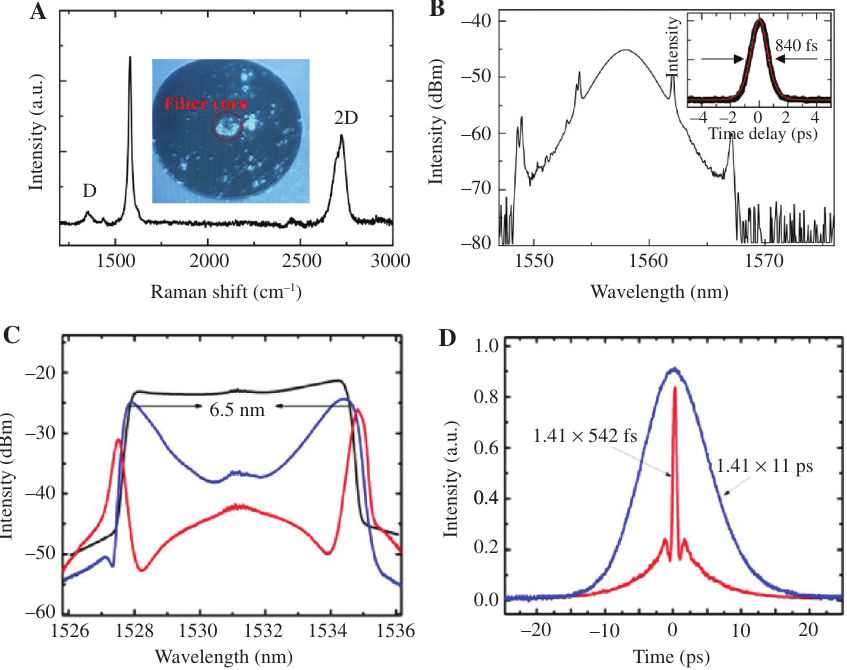
Figure 2: Mode-locked results enabled by graphene and GO. (A) Raman spectrum of the graphene (inset: graphene optically deposited on fiber tip). (B) HML spectrum (inset: the autocorrelation trace of the 26th harmonic). (C) Spectra: before pulse compression (black curve), after 50-m single-mode fiber (blue curve), and after 75-m single-mode fiber (red curve). (D) Autocorrelation trace of chirped (blue curve) and dechirped pulses (red curve). (A) and (B) are reproduced with permission from Ref. [81]. Copyright 2019 CLP Publishing. (C) and (D) are reproduced with permission from Ref. [192]. Copyright 2012 OSA